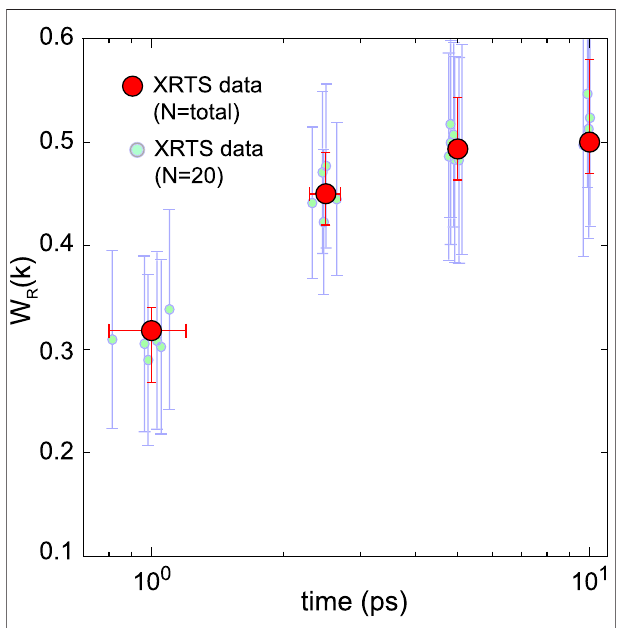
FIGURE 3 | (color online) Time resolved evolution of the elastic XRTS scattering intensity calculated with the average on-target signal that accumulatedforN=20hits(bluecircles)andforthetotalintegratedsignal(red circles).